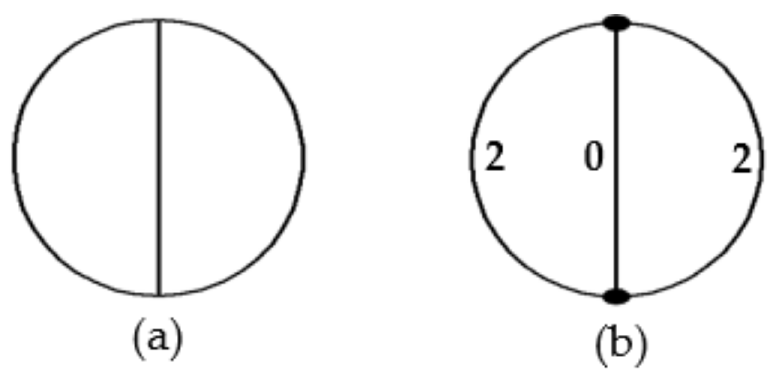
Figure 3. ( a ) Topological diagram; ( b ) Weighted topology